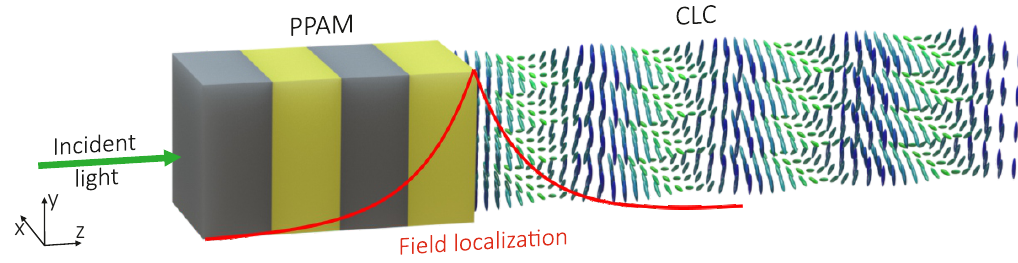
Figure 1. Schematic representation of the interface between a dielectric polarization preserving anisotropic mirror and a cholesteric liquid